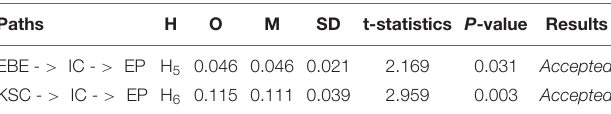
TABLE 5 | Indirect effects of the